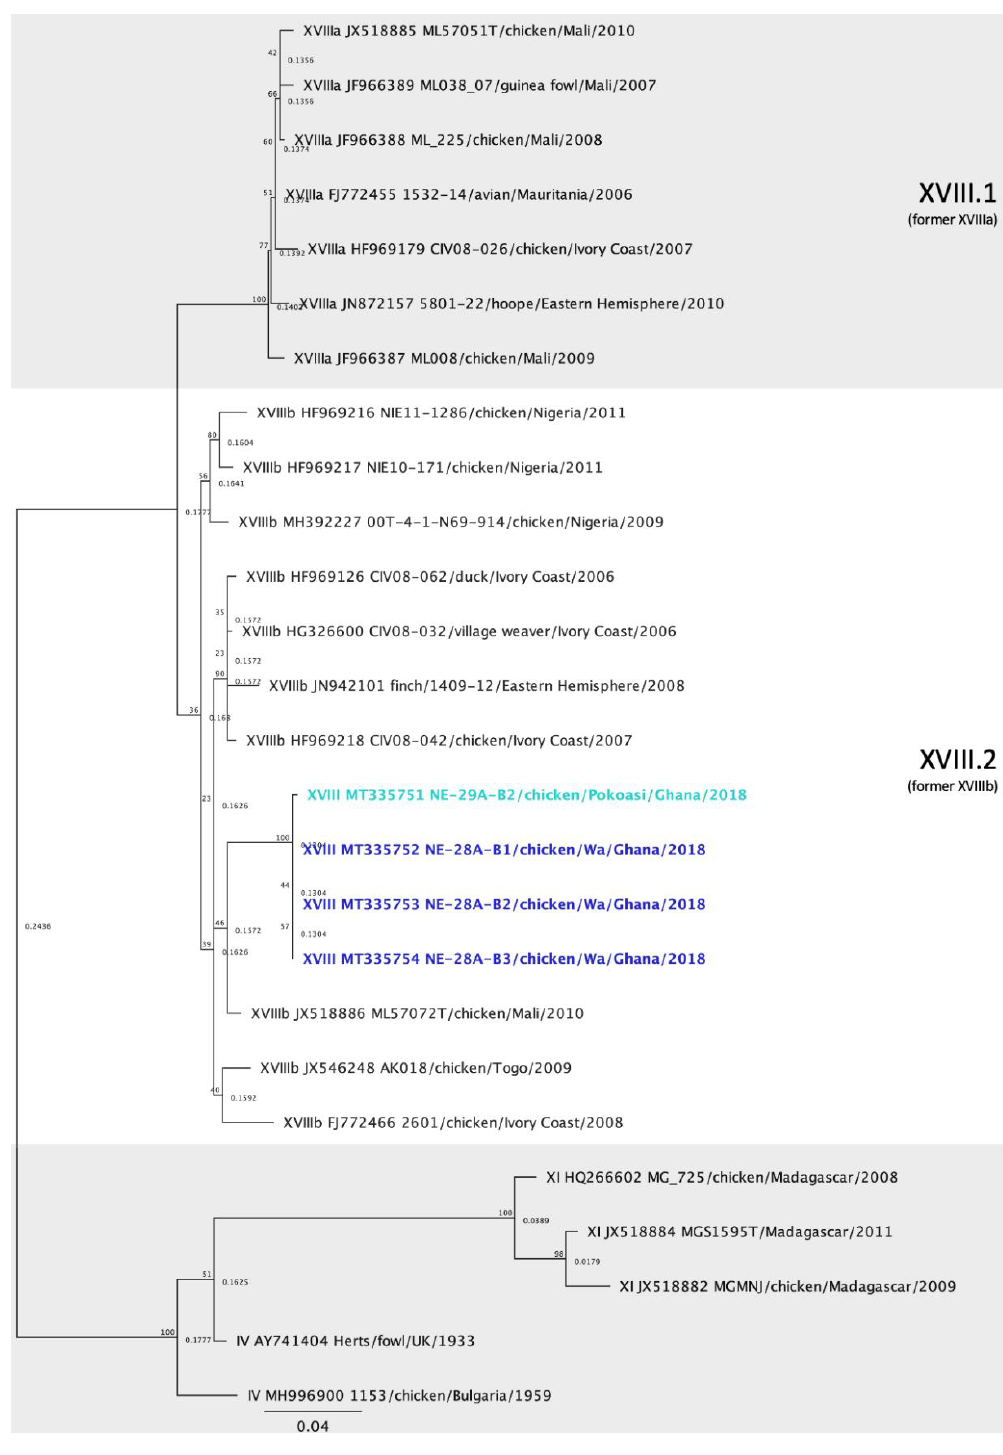
Figure 6. Phylogenetic analysis of Newcastle disease virus genotype XVIII isolates using a 615-bp fragment of the fusion gene with the maximum likelihood method with 1000 bootstrap replicates. Of the 26 sequences used, 3 were collected from diseased chickens from Wa and one from Pokoasi, Ghana (bolded and colored), 17 represent other genotype XVIII isolates [5], and 5 are outliers (2 from genotype IV and 3 from genotype XI). The Roman numerals on the right represent the genotypes the isolates belong to. The previous terminology [4] is listed below the current nomenclature in parenthesis for reference. The colors represent the geographic location of the isolates (light blue = Pokoasi and dark blue = Wa).